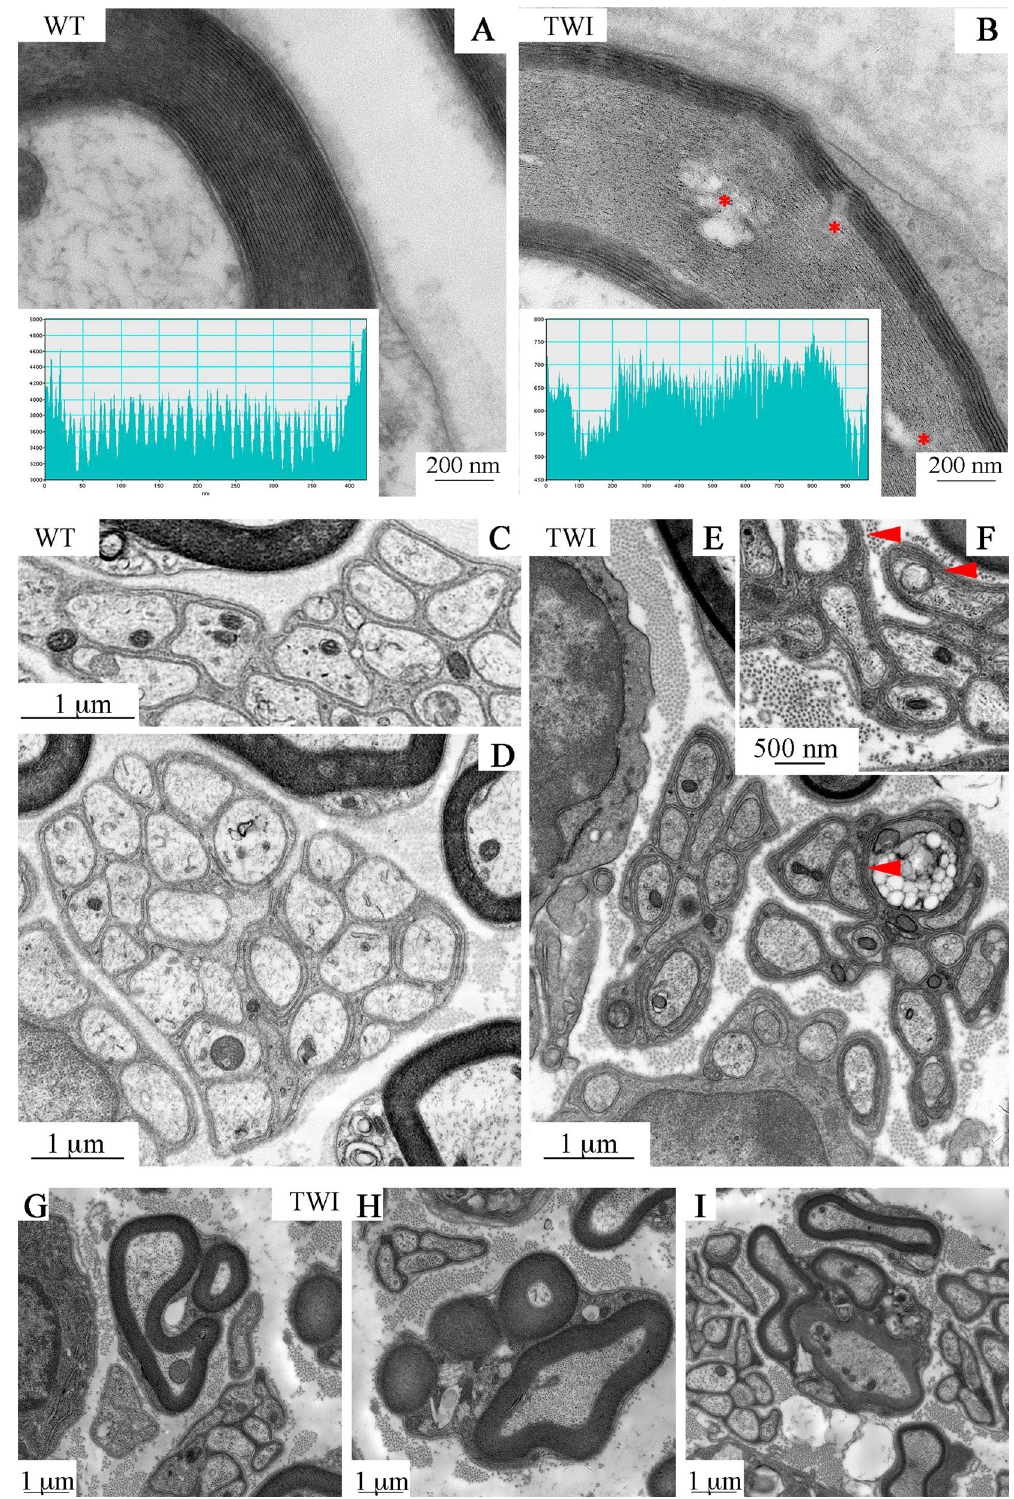
Figure 3. Myelinating and non-myelinating SCs in sciatic nerves of P30 WT and TWI mice. ( A,B ) Myelin sheath structure in WT and TWI samples; the insets show the image profile of a line crossing the myelin sheath. Gaps between consecutive layers are visible in TWI mice (B, * ). ( C–F ) Remak bundles in WT sciatic nerves ( C,D ) and TWI ones ( E,F ). TWI mice Remak bundles show a denser cytoplasm compared to WT ones and a more complex winding (arrowheads). ( G–I ) Examples of multiple myelination processes in the sciatic nerve of P30 TWI mice. ( G ) type 1 MMP, ( H ) type 2 MMP, ( I ) type 3